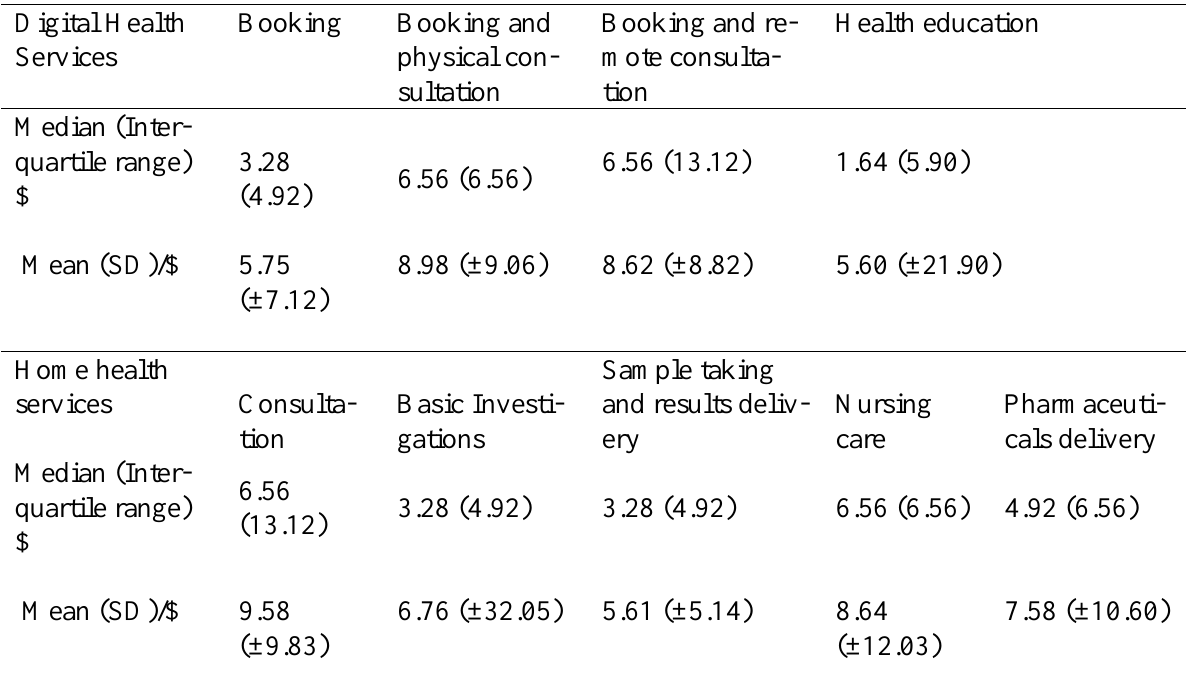
Table 3: Willingness to pay for digital and home healthcare services in